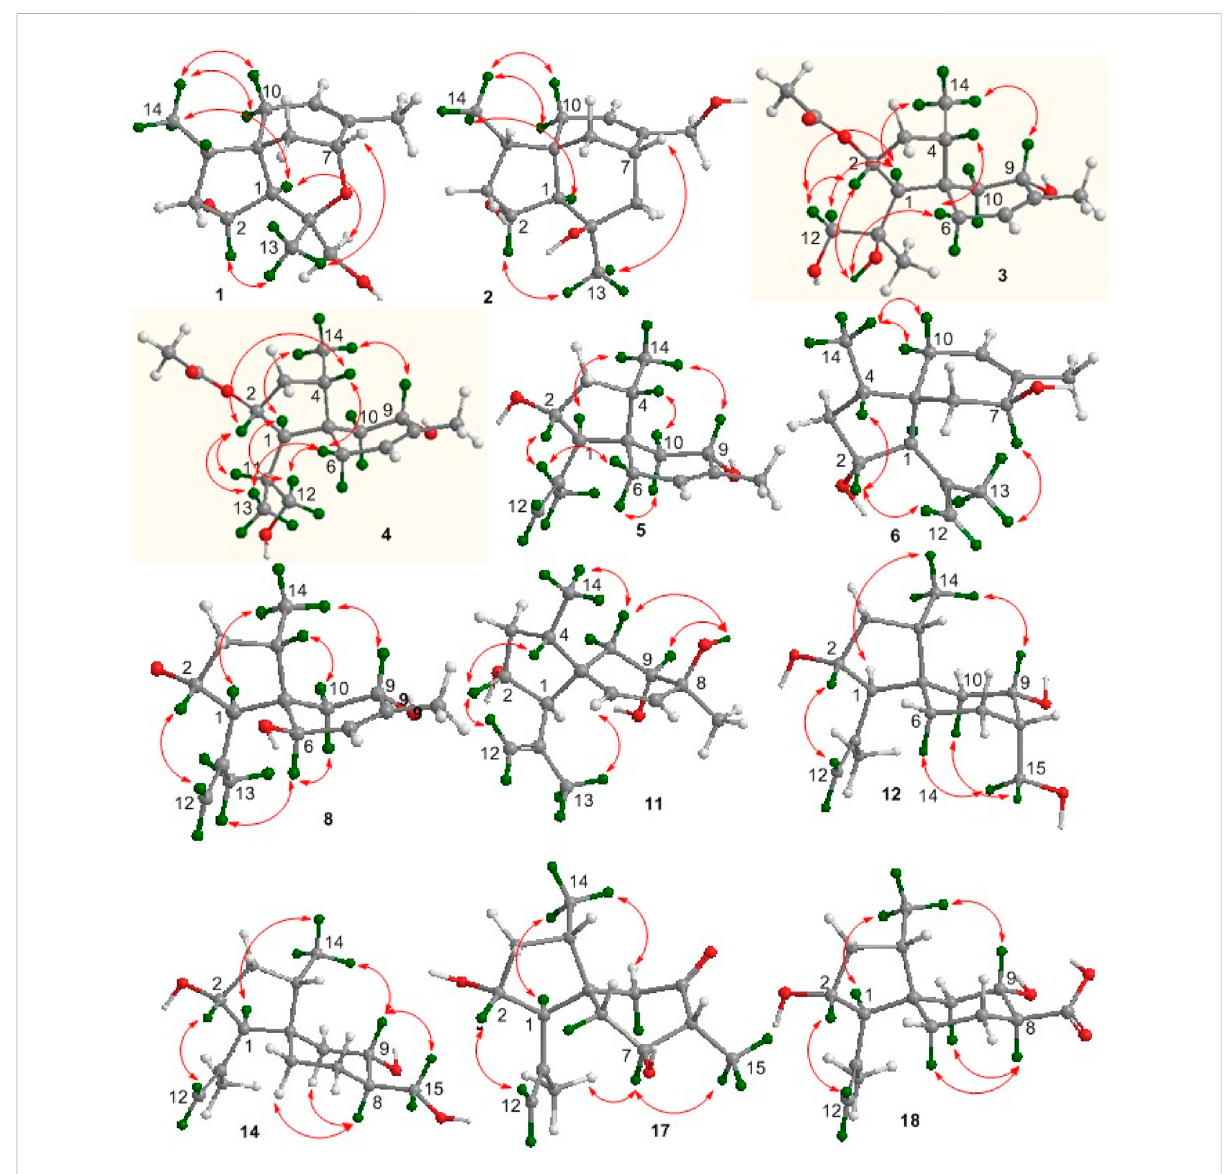
FIGURE 4 Key NOE correlations of 1 – 4 , 12 , 14 , and 17 – 18